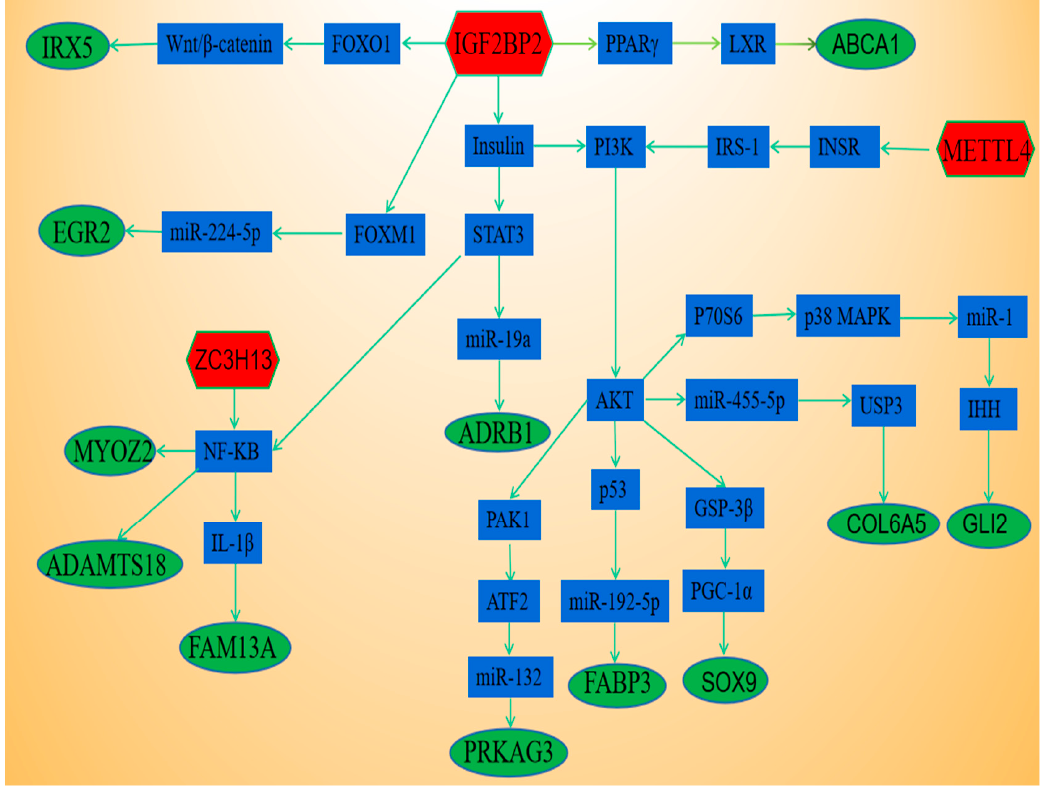
Figure 7. Regulation of fat related genes by methylase.